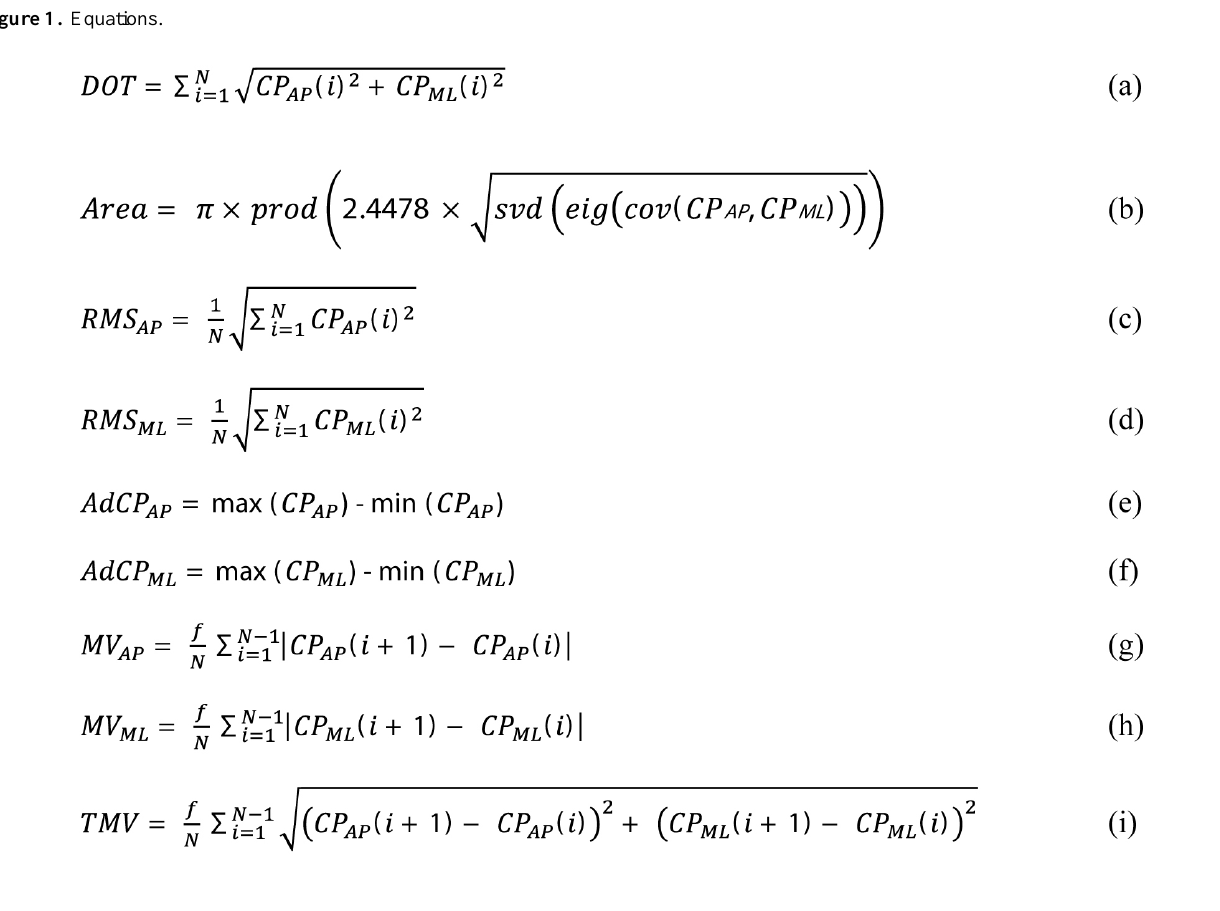
ICC results for agreement between Wii Balance Boards and results of the F and Friedman tests are presented in Table 1. Low agreements were found for variables derived from ML displacements (ICC values of .334 and .345 for RMS AdCP , respectively). Strong agreements were found for ML